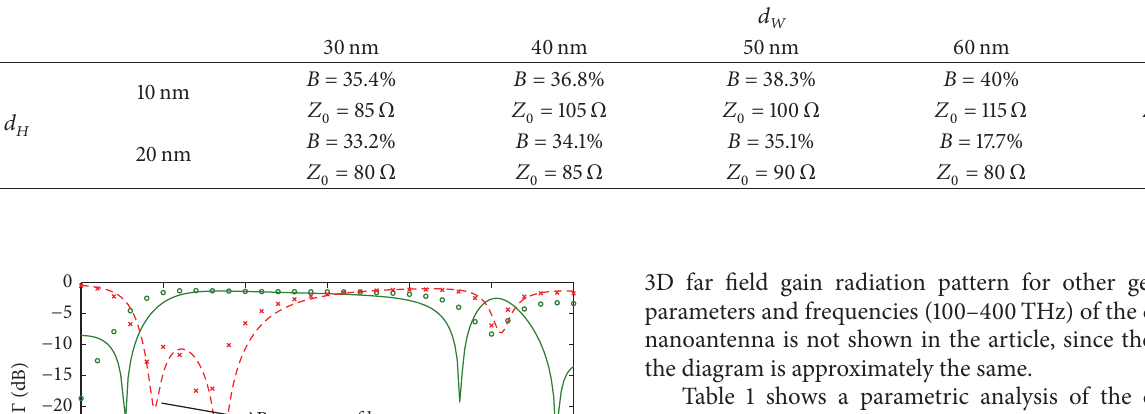
Table 1: Results of parametric analysis of the composed nanoantenna (calculated through Comsol).